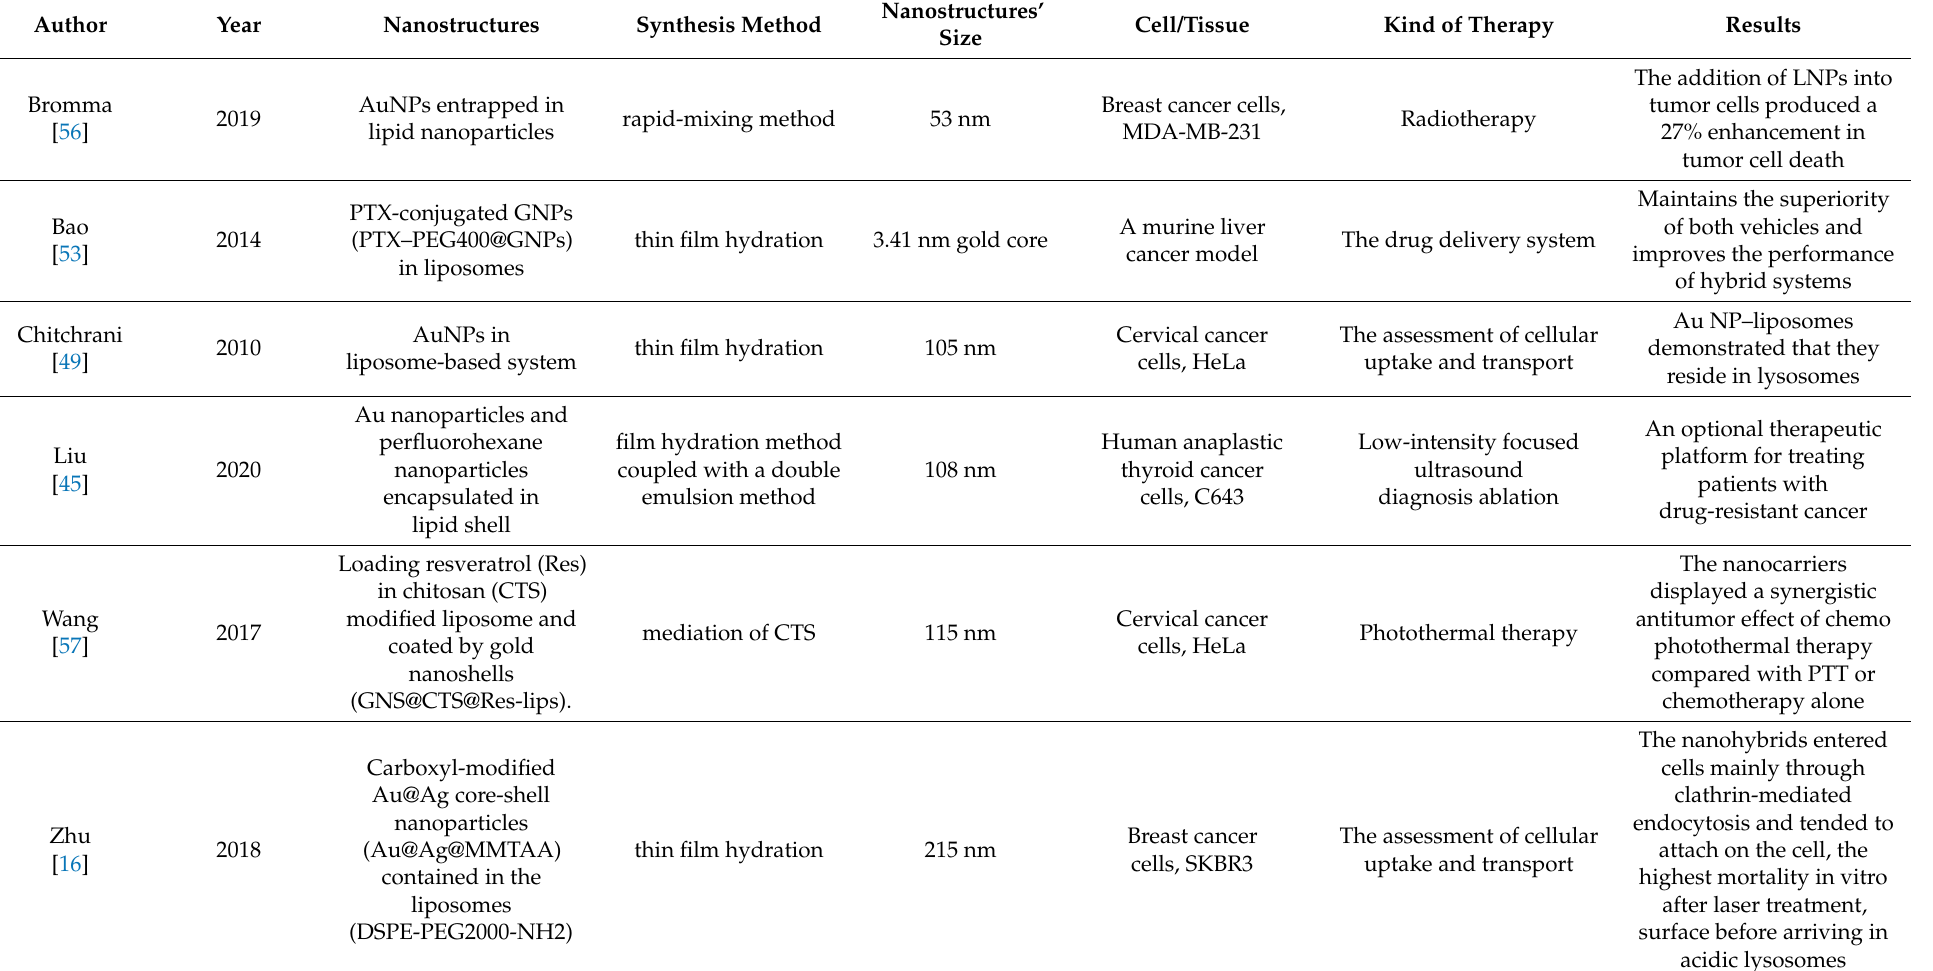
Table 1. Selected applications of liposomes with metallic nanoparticles in cancer